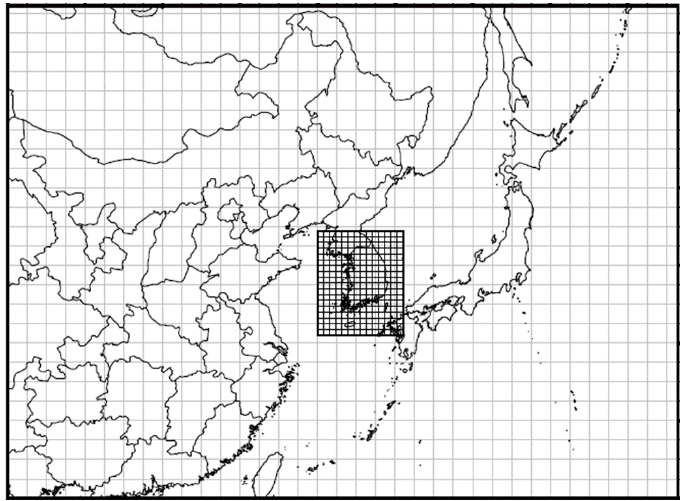
Figure 1. Model domain and grid configuration of the global to mesoscale air quality forecast and analysis system (GMAF).